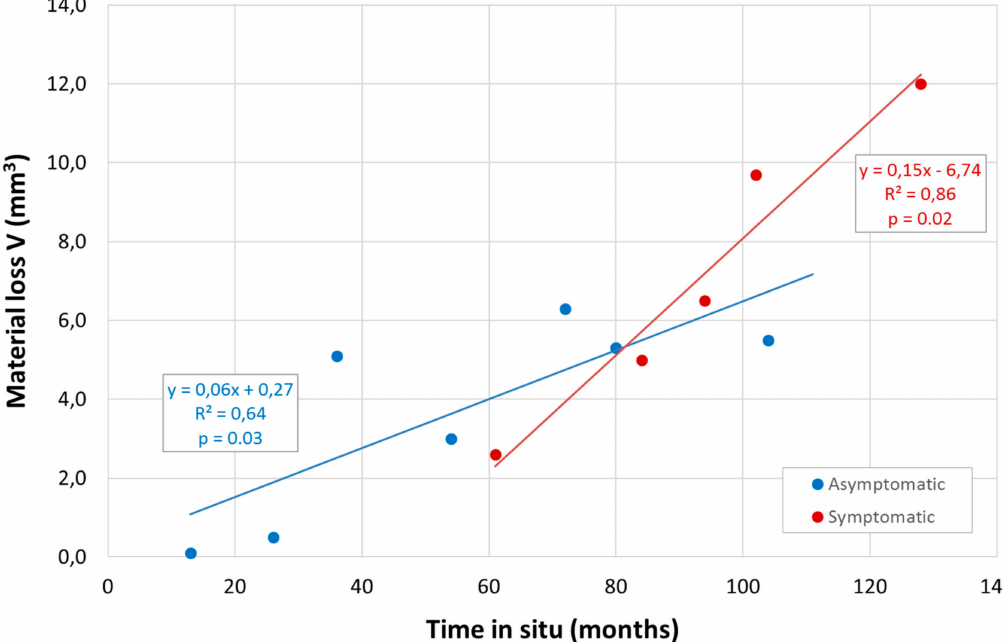
Figure 5. The volumetric material loss versus time in situ of seven asymptomatic and five symptomatic retrieved modular CoCr neck components. Note: asymptomatic neck adapter #8 was excluded from the regression